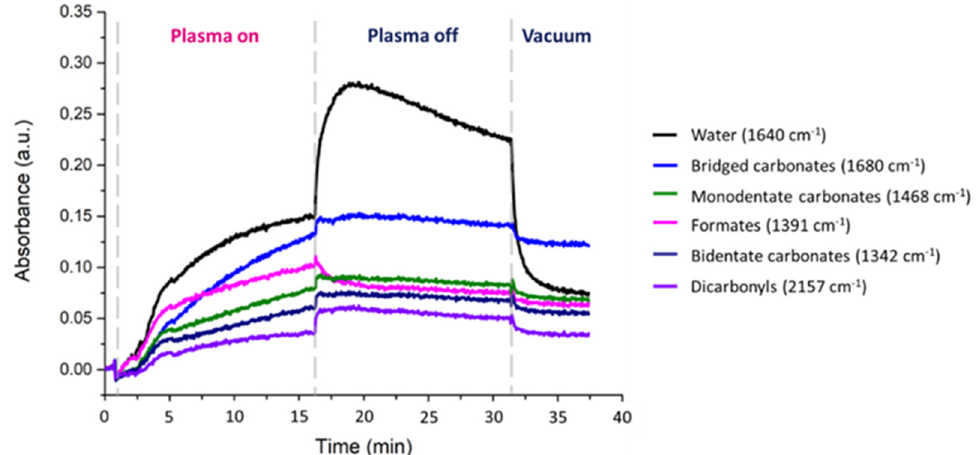
Figure 8. Evolution of the intensity of the bands (shown as absorbance) of relevant species in the FTIR spectra while the plasma is ignited (and thus the reaction is occurring), when the plasma is turned off and, finally, when the system is put under vacuum.